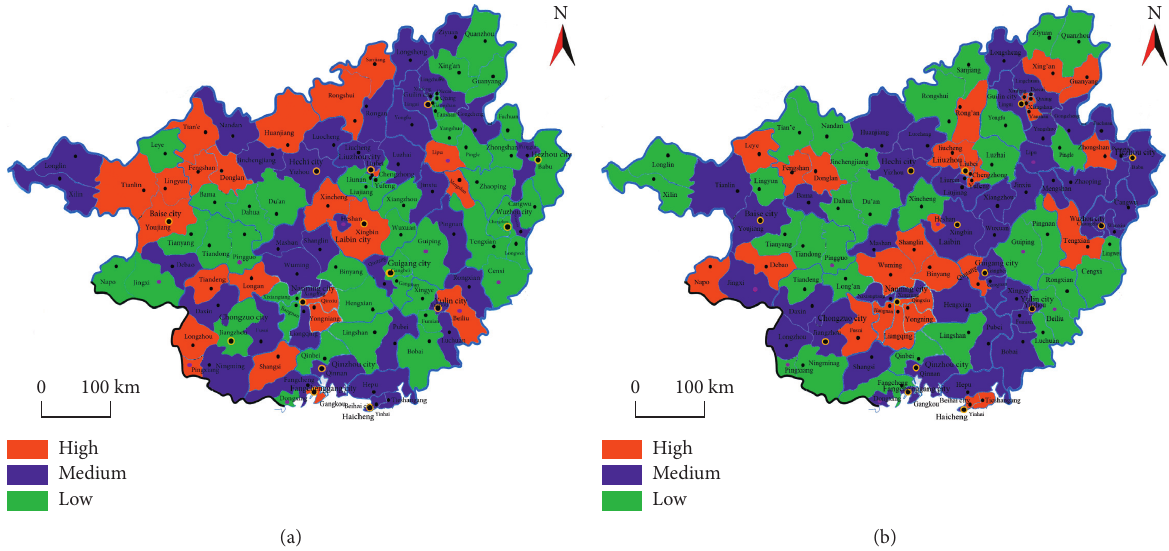
Figure 4: Equilibrium distribution pattern of compulsory education resource allocation. (a) Primary school. (b) Junior secondary